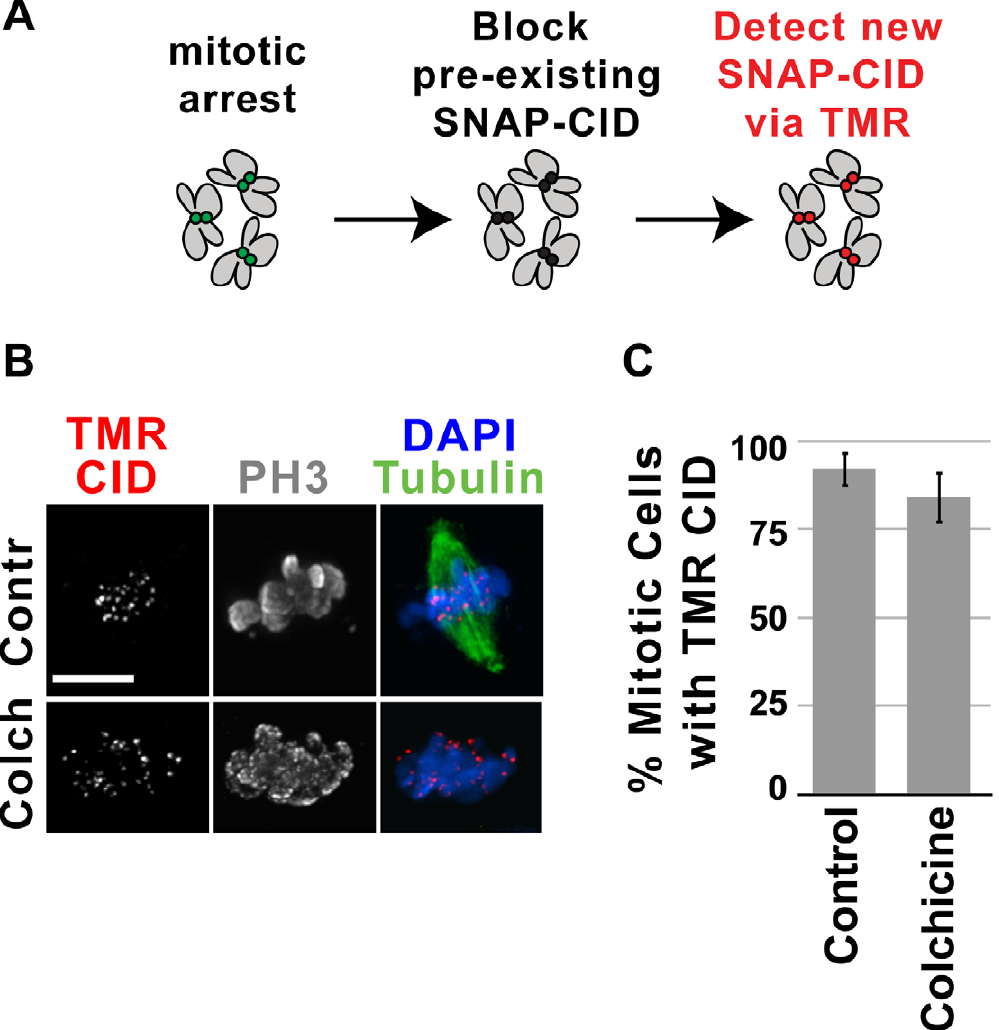
Figure 5. New CID recruitment occurs independently of microtubules. A) Experimental design for monitoring the recruitment of new CID during mitotic arrest induced by colchicine. Clonal S2 SNAP-CID cells were arrested in mitosis with either 12.5 m M colchicine or no drug (Contr) for two hours, then incubated with the BTP-block to quench all pre-existing SNAP-CID, and chased for four hours in the presence of colchicine. Newly- synthesized SNAP-CID was then detected by labeling with TMR. B) Representative images of SNAP-CID S2 treated (Colch) and not treated (Contr) with colchicine. TMR-labeled CID is shown in red, tubulin in green, phospho H3 in gray, DAPI in blue. Note that after treatment with colchicine cells lack spindle microtubules. New SNAP-CID recruitment occurs with efficiency comparable to untreated cells when cells are blocked in metaphase with colchicine (p=1, Fisher’s exact test). C) Control cells (no drug, n=27) and cells treated with colchicine (n=25) were scored for the presence or absence of centromeric TMR-labeled CID. Percent of cells (y-axis) with visible centromeric new SNAP-CID did not differ significantly (p=0.4501, Fisher’s exact test) in control cells compared to treated cells (x-axis). Error bars indicate standard error.